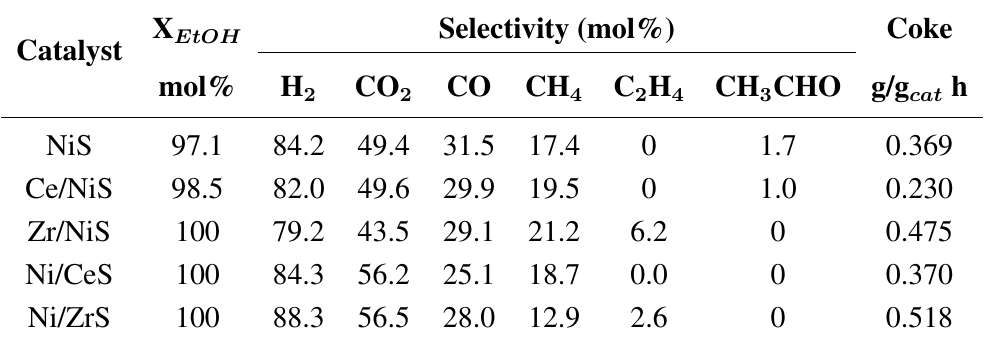
Table 4. Results on ethanol steam reforming obtained with the Ni/SiO Ce or Zr (atmospheric pressure; T: 600 ◦ C ; weight hourly space velocity; WHSV: 12.7 h − 1